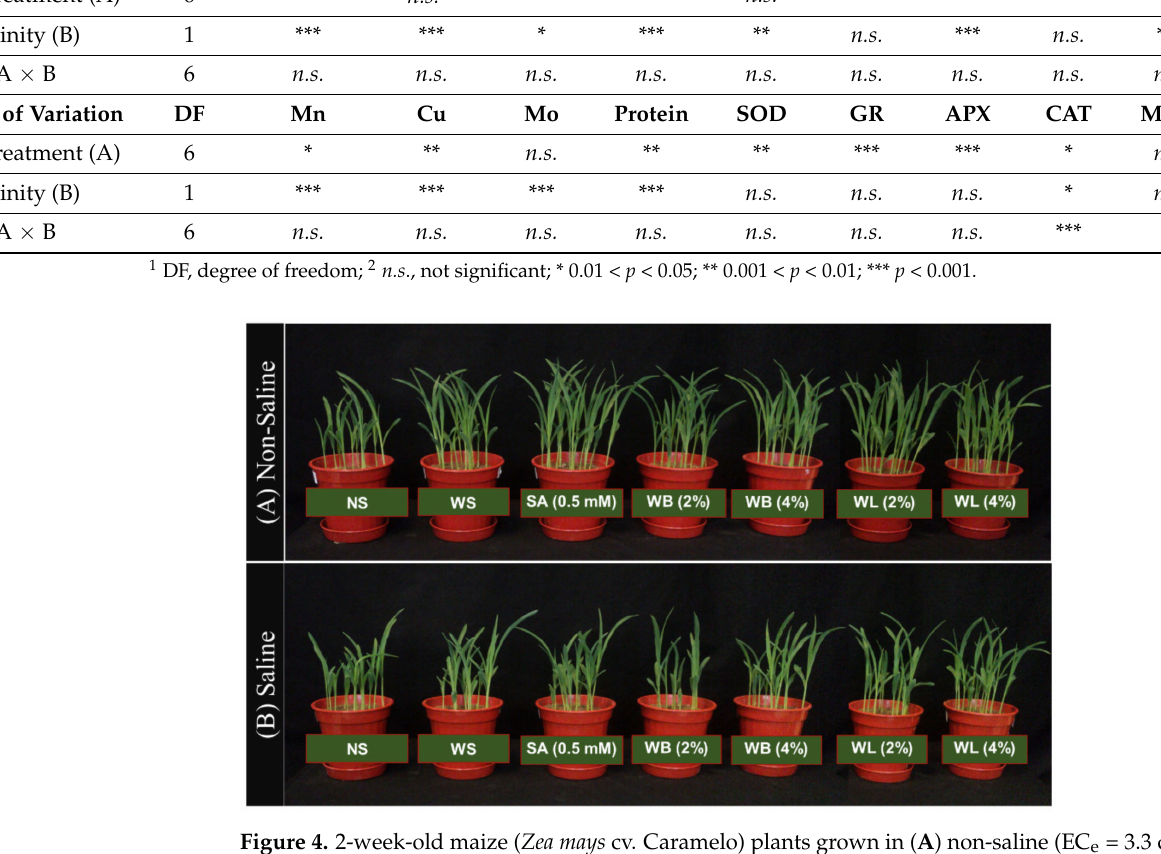
Figure 4. 2-week-old maize ( Zea mays cv. Caramelo) plants grown in ( A ) non-saline (EC e = 3.3 dS/m) vs. ( B ) saline (EC e = 7.8 dS/m) soil from seeds treated with various agents (NS, non-soaked; WS, water-soaked; SA, salicylic acid (0.5 mM); WB, willow bark extract (2% or 4% w / v ); WL, willow leaf extract (2% or 4% w / v )).